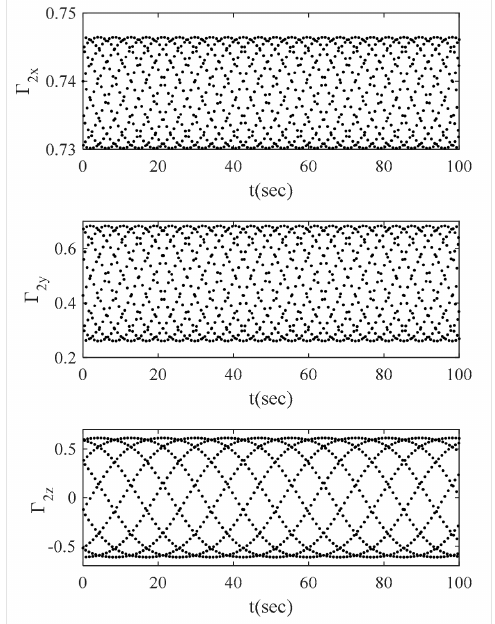
Figure 24. The results of the attitude of the y axis under the complete Lie group model.